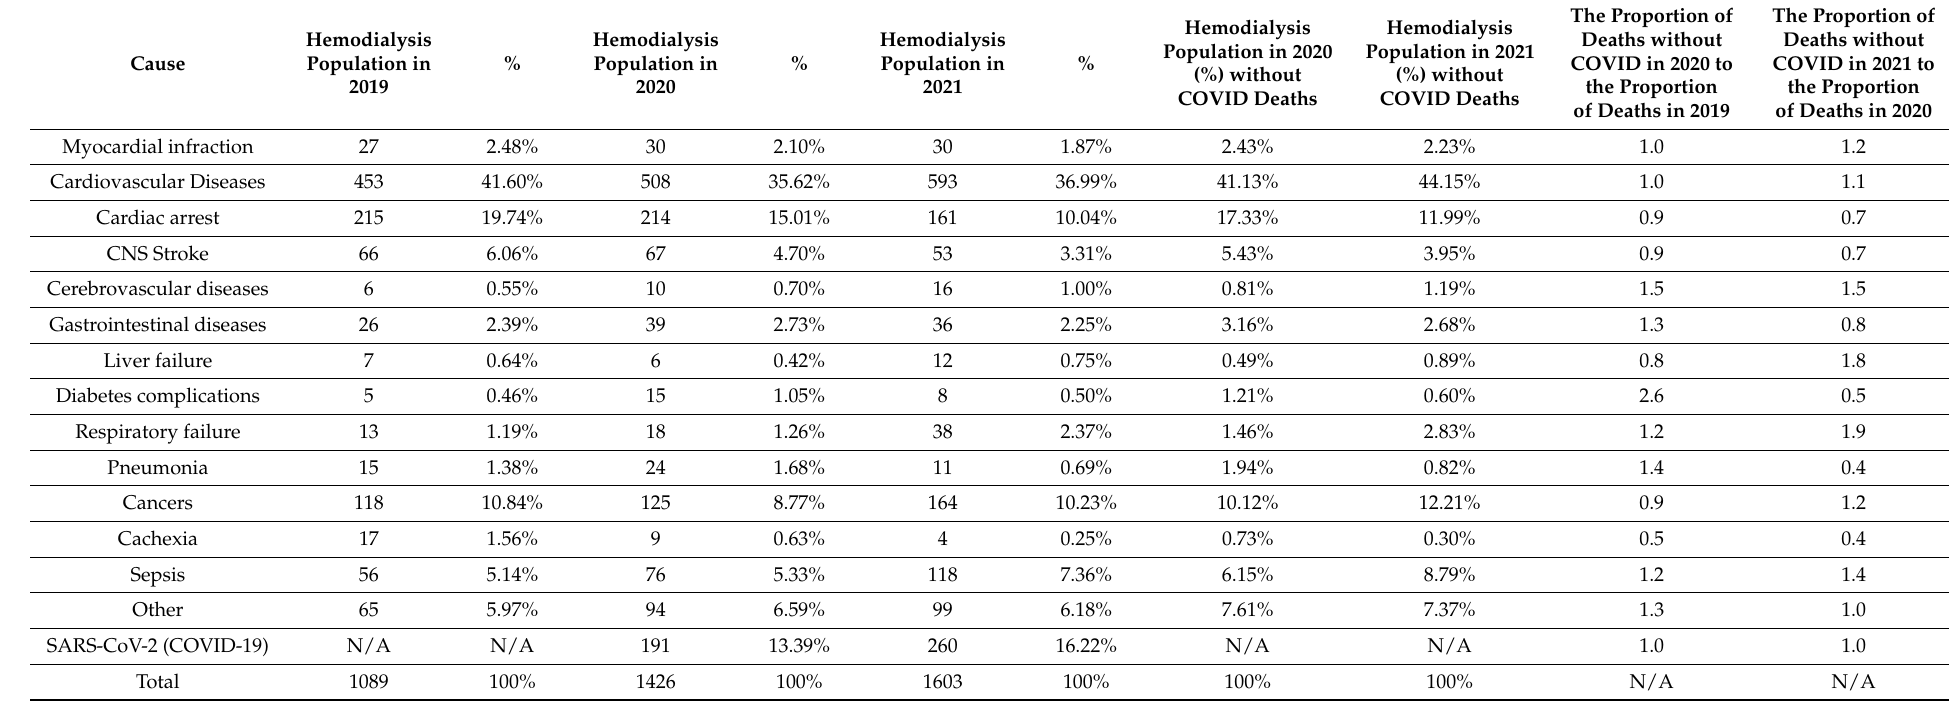
Table 2. The proportion of specific cause categories in the total number of